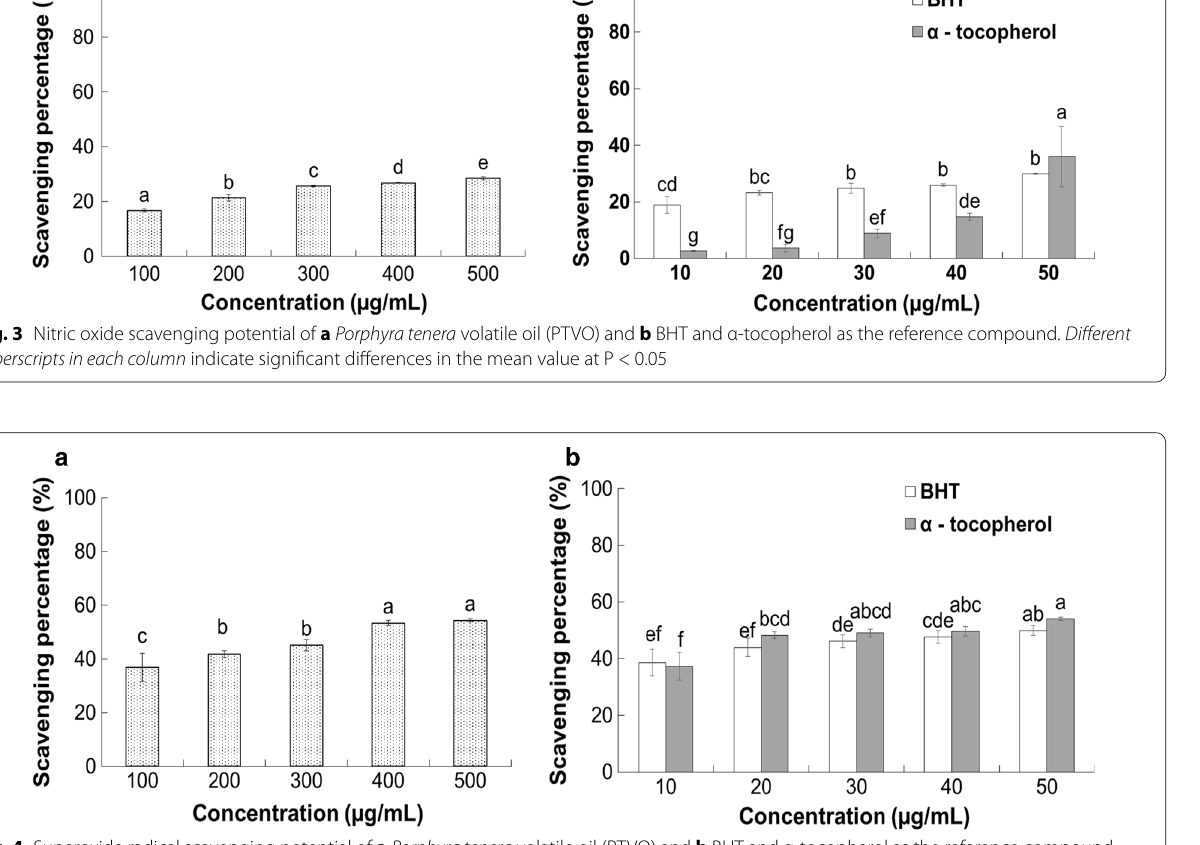
Fig. 4 Superoxide radical scavenging potential of a Porphyra tenera volatile oil (PTVO) and b BHT and α‑tocopherol as the reference compound. Different superscripts in each column indicate significant differences in the mean value at P <